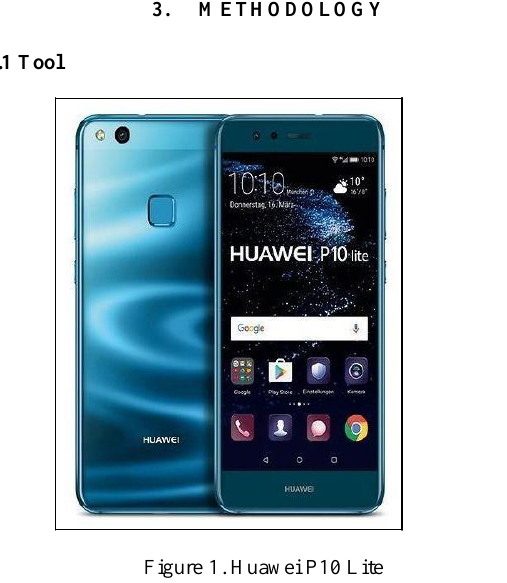
Figure 2 The collection of software used in this study